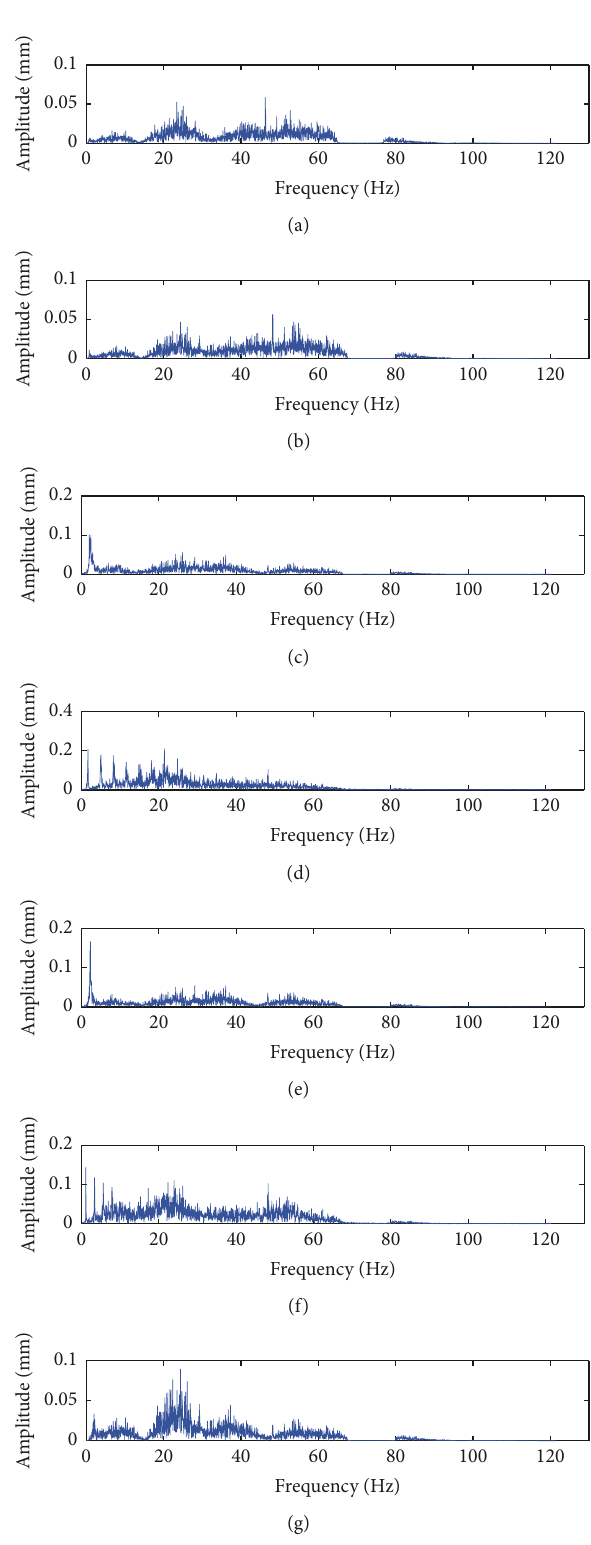
Figure 3: Comparison of frequency-domain analysis of bogie signals under 7 health condition: (a) normal condition; (b) failure of the air springs; (c) failure of the antiyaw damper; (d) failure of the lateraldamper; (e) failure of the air spring + the antiyaw damper; (f) failure of the air spring + the lateral damper; (g) failure of the lateral damper + the antiyaw